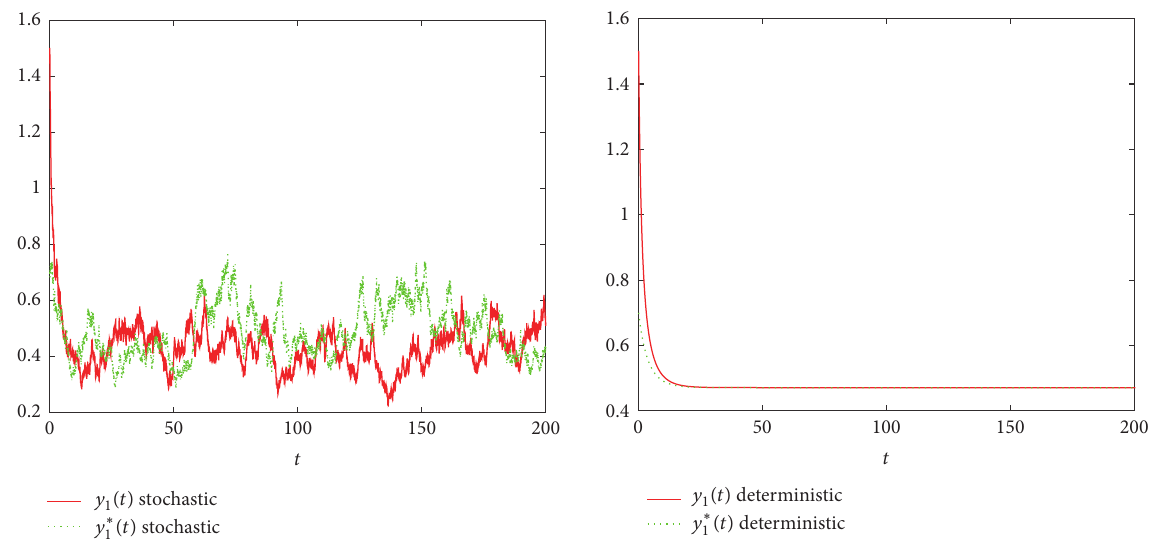
Figure 6: The path curve of 𝑦 1 (𝑡) and 𝑦 ∗ 1 (𝑡). Red: solution of model (62) for 𝛾 1 (𝜃) = (1.5,1.3, 1) . Green: solution of model (62) for 𝛾 ∗ 1 = (0.7, 0.8, 0.6) .